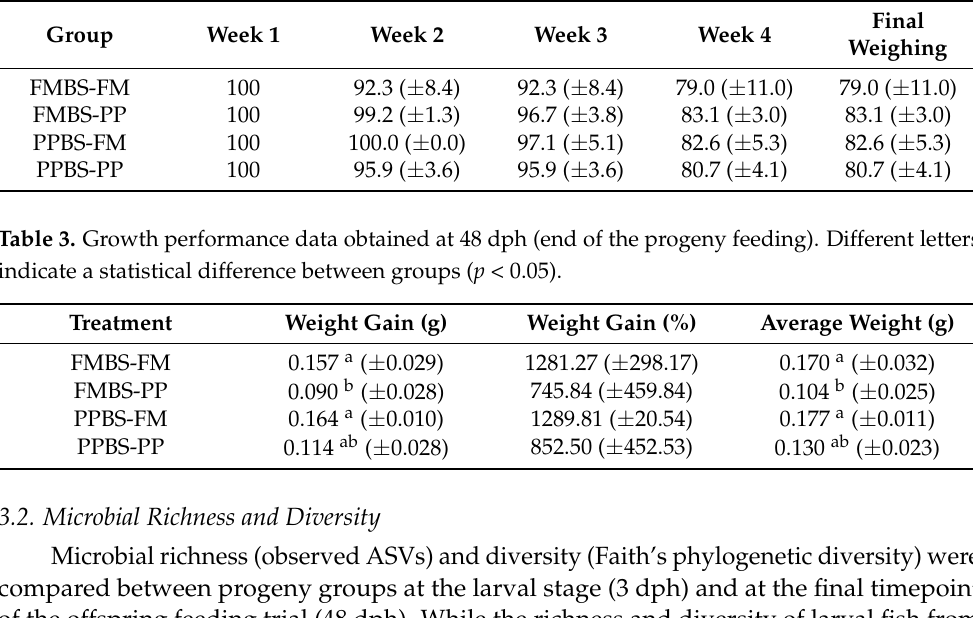
Table 2. Survival (%) of zebrafish throughout the experiment.